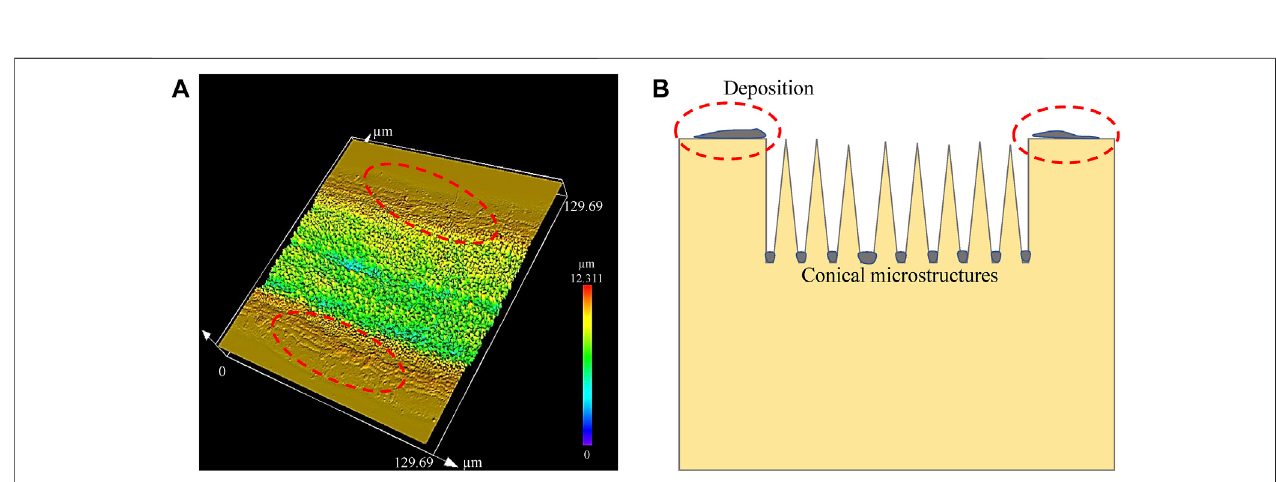
FIGURE 2 | Deposition on the single row fabricated with laser inducing process. (A) 3D image of the processing row and (B) schematic of the deposition laterally.